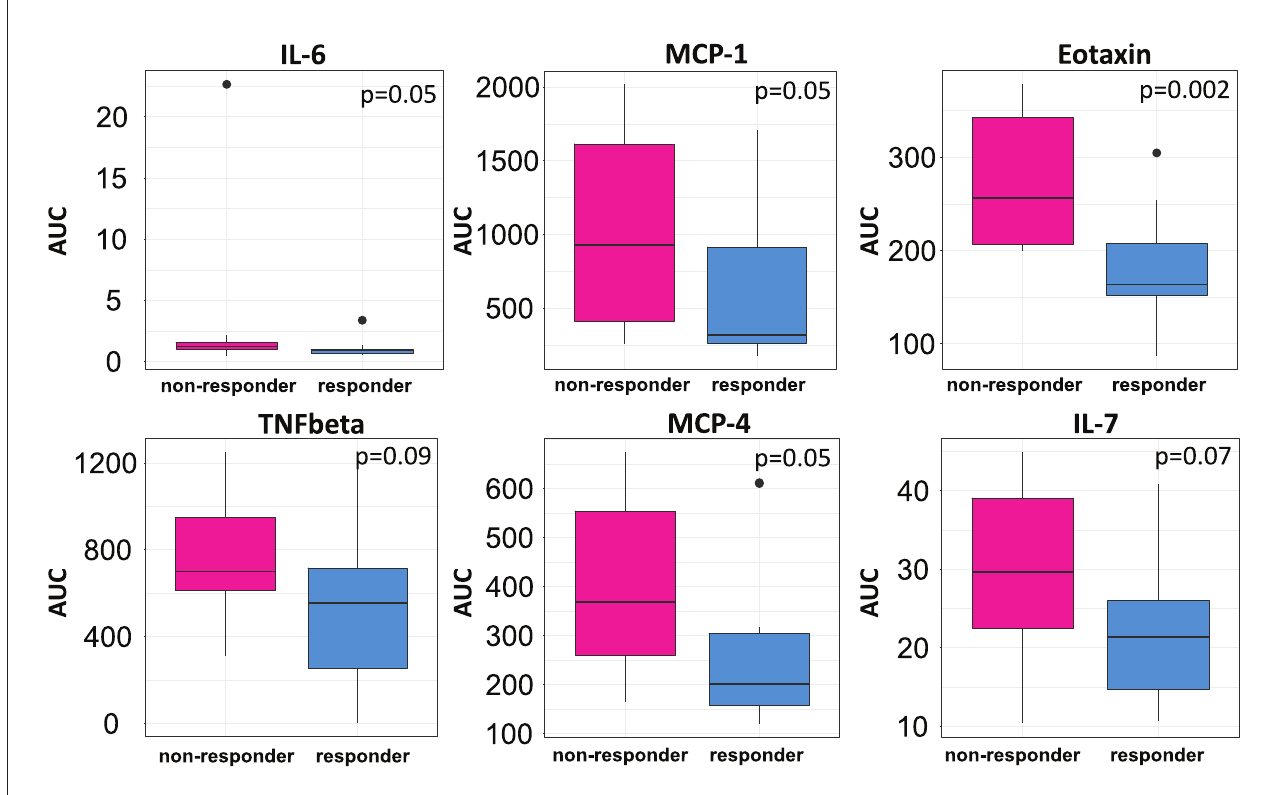
FIGURE 5 | Cytokine levels in filgrastim response groups. Differences in serum cytokine levels between responding (Turquoise) and non-responding patients (Pink; N = 15 in each group) were assessed by area under the curve (AUC) over the first 9 months of filgrastim treatment (IL 6 p = 0.05, MCP 1 p = 0.05, eotaxin p =